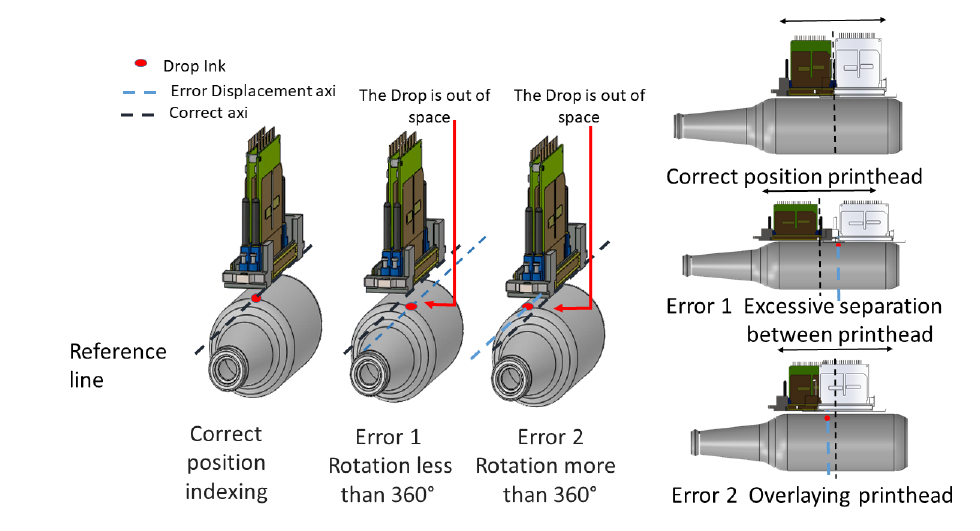
Figure 3. Print head cylinder rotation and translation